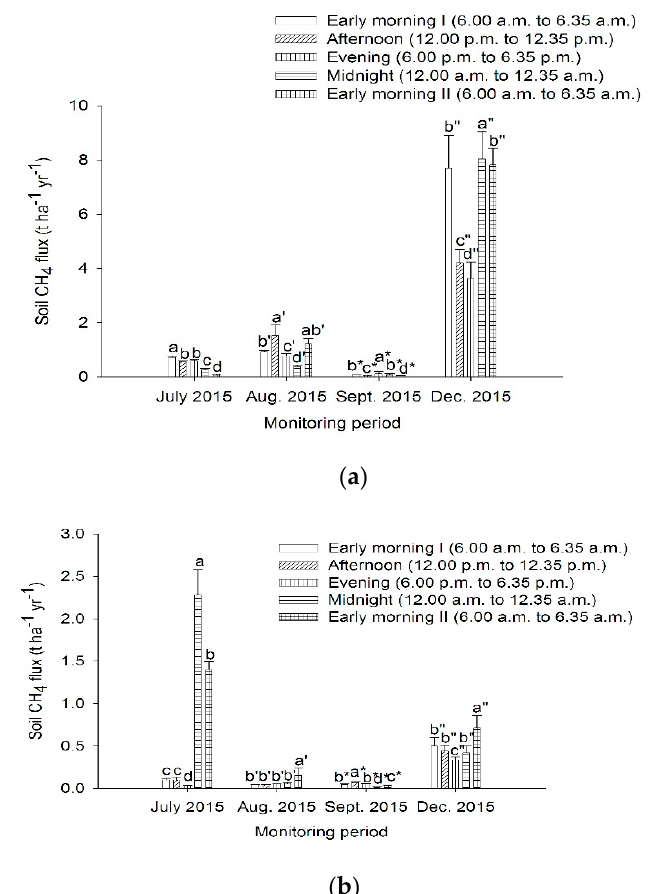
Figure 8. Soil CH 4 emissions (at different times of the day) from a peat soil grown with pineapples in lysimeters under simulated water table fluctuation ( a ) low water table and ( b ) high water table throughout the dry (July and August 2015) and wet (September and December 2015) seasons. Error bars represent standard error and soil mean fluxes with different letters and noted by prime, asterisk, and double prime are significantly different using DNMRT at p ≤ 0.05.